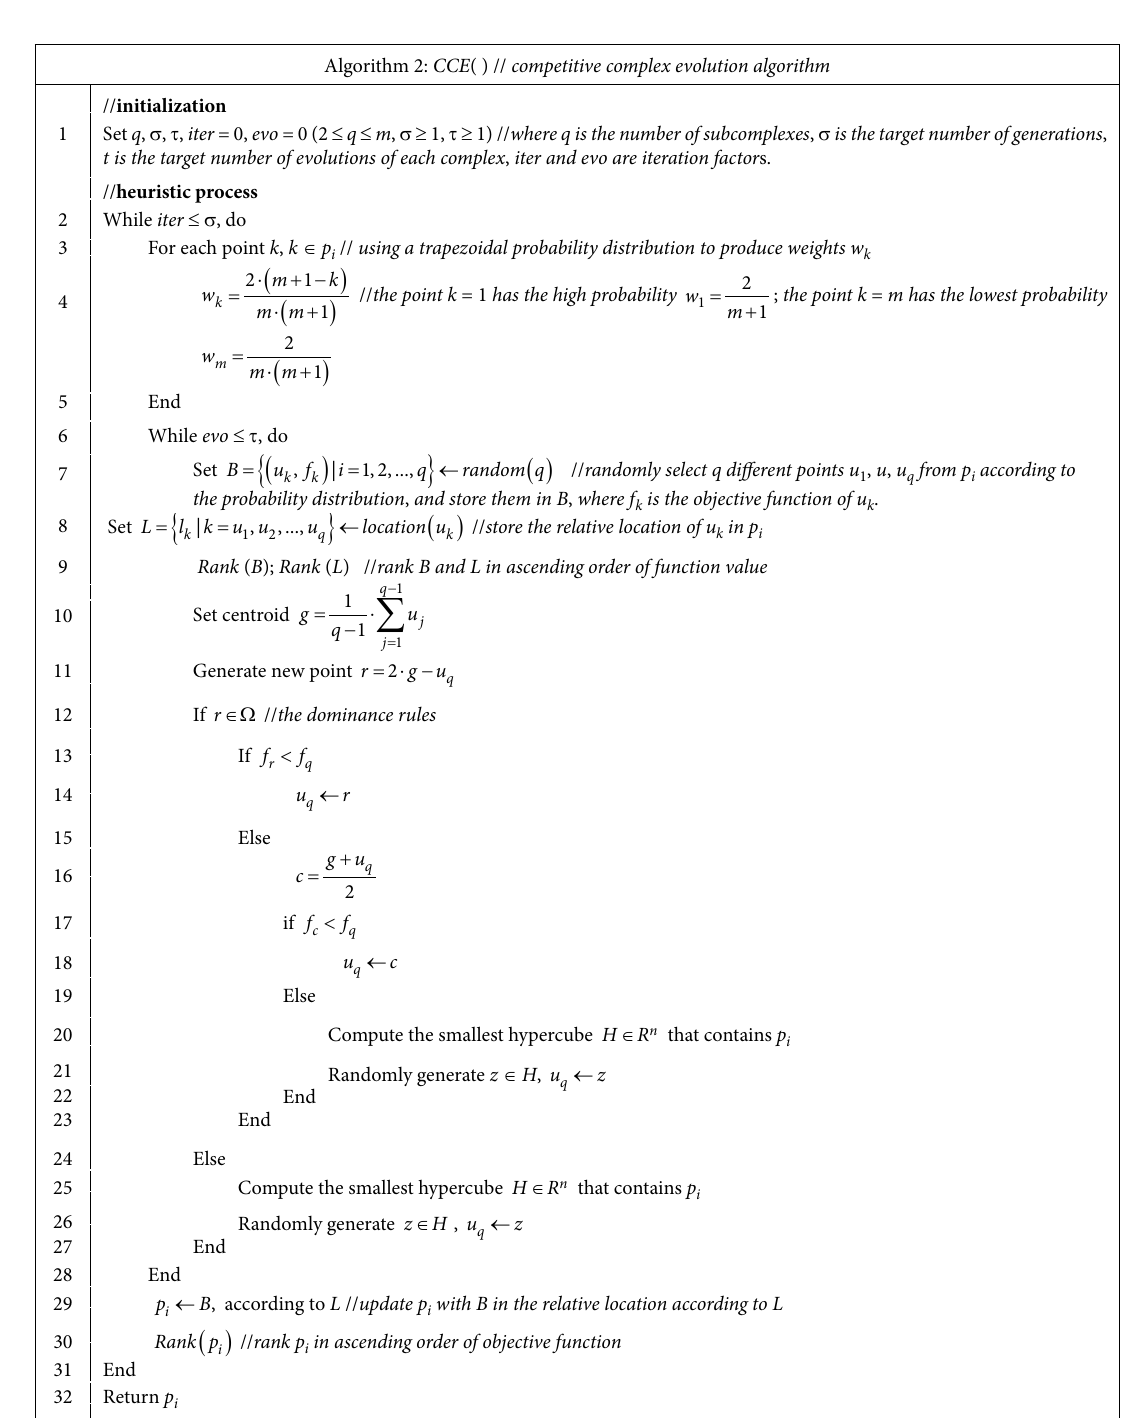
Algorithm 2: CCE ( ) // competitive complex evolution